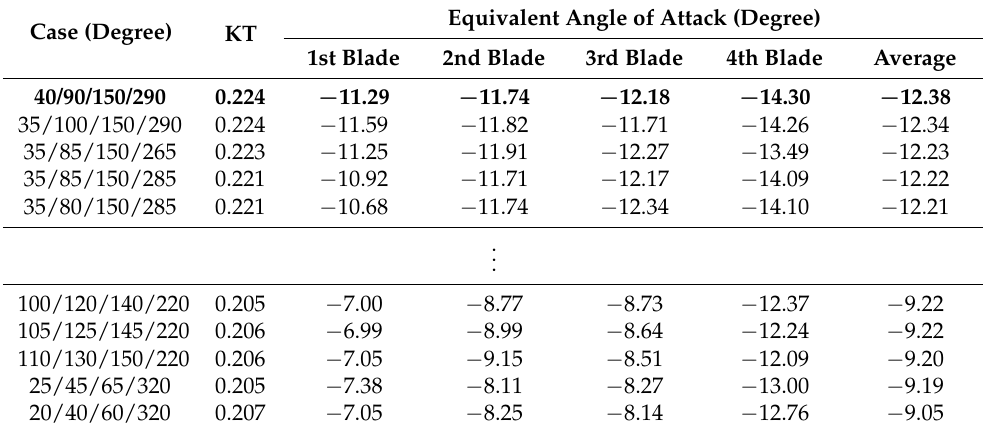
Figure 10. Range of angles for the optimization of the blade position (looking upstream). Table 7. Equivalent angle of attack of each blade calculated by the potential program for some typical cases ( bold face is the most optimum case).